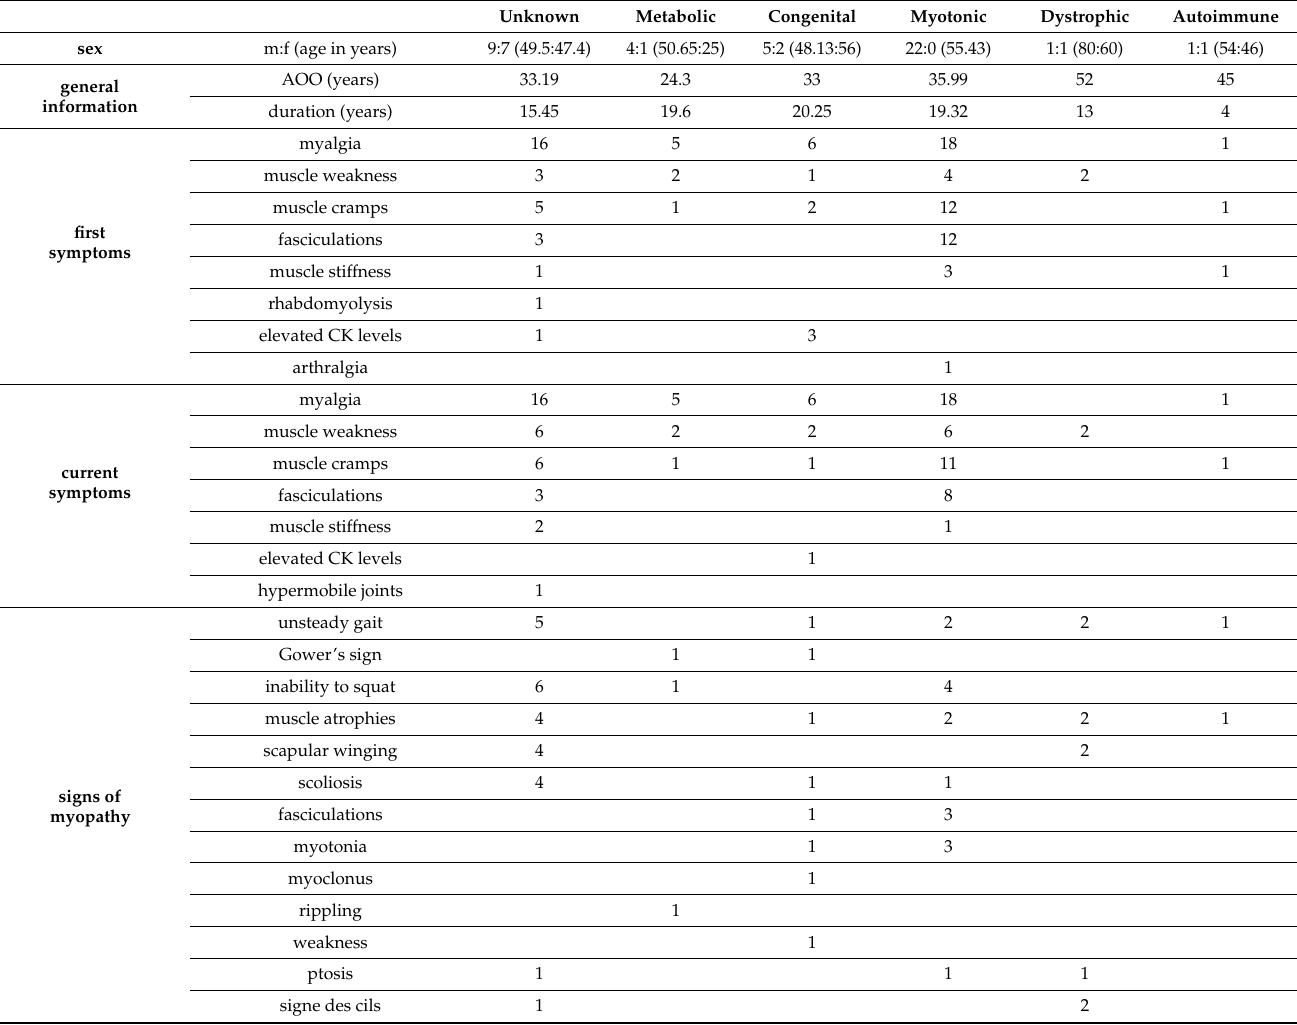
Table 1. Patient overview and demographics